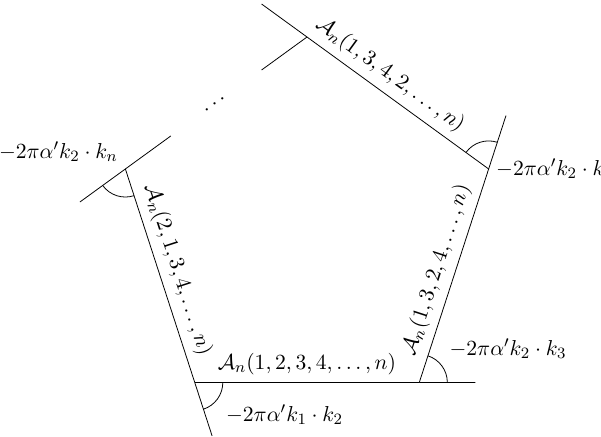
Figure 2. Plahte diagram for N -point open tachyon string